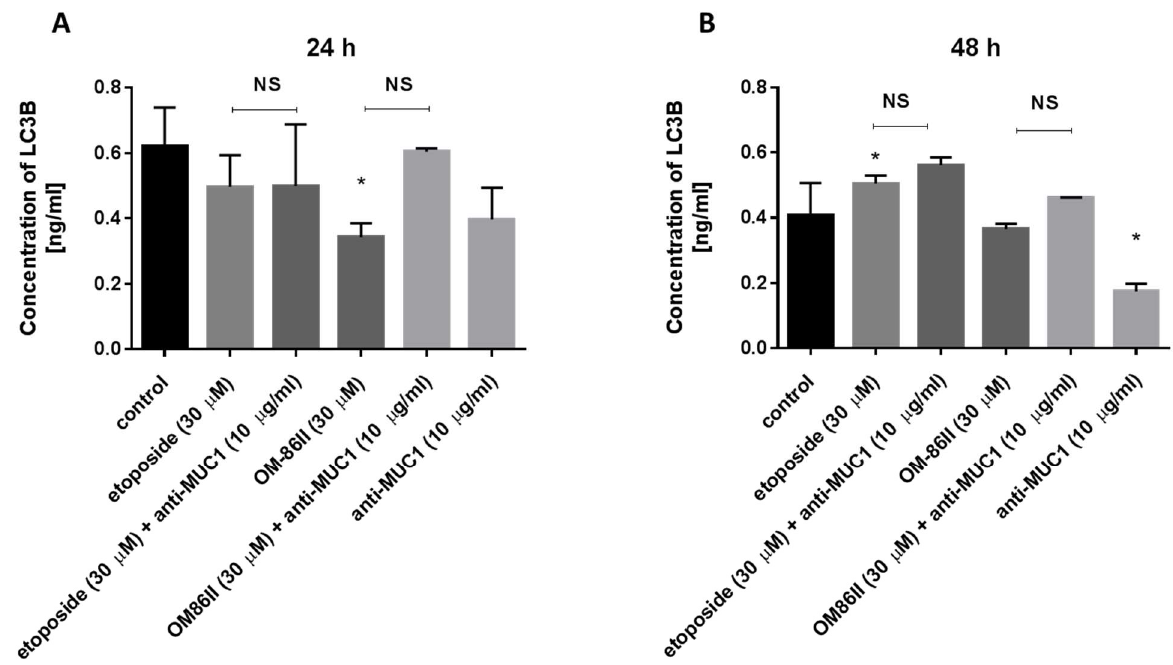
Figure 13. The concentration of LC3B in human gastric cancer AGS cells after 24 h ( A ) and 48 h ( B ) of incubation with anti-MUC1 (10 µ g/mL), OM-86II (30 µ M), OM-86II + anti-MUC1 (30 µ M + 10 µ g/mL), etoposide (30 µ M) and etoposide + anti-MUC1 (30 µ M + 10 µ g/mL). Data are presented in ng/mL. * p < 0.05 vs. control group; MUC1, mucin-1; OM-86II, octahydropyrazin[2,1-a:5,4-a (cid:48) ]diisoquinoline derivative; NS, not significant.